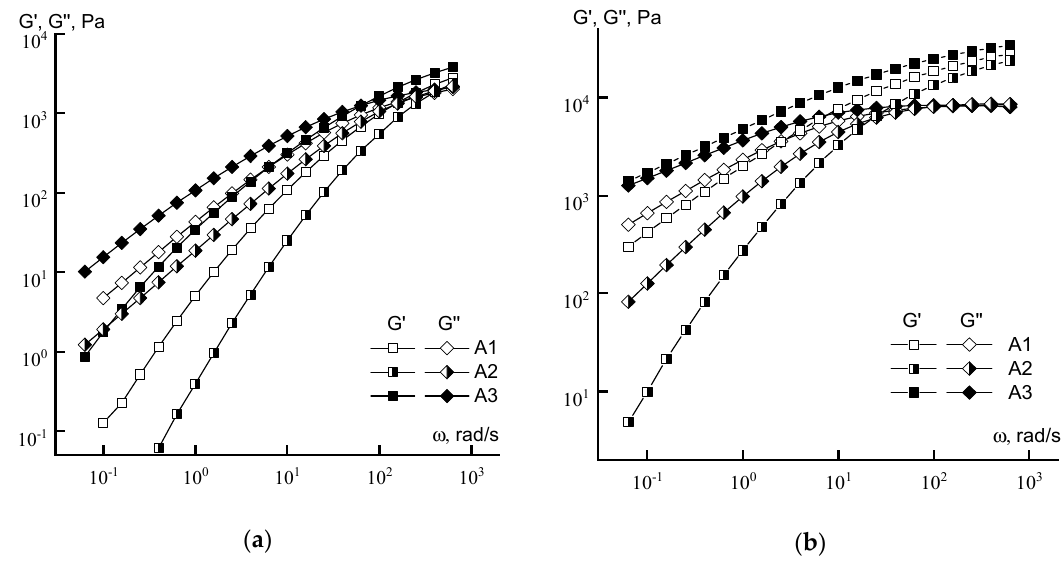
Figure 7. The dependence of the viscosity of series A and B copolymer solutions, measured at a shear rate of ~ 0.1 s –1 , on the concentration.